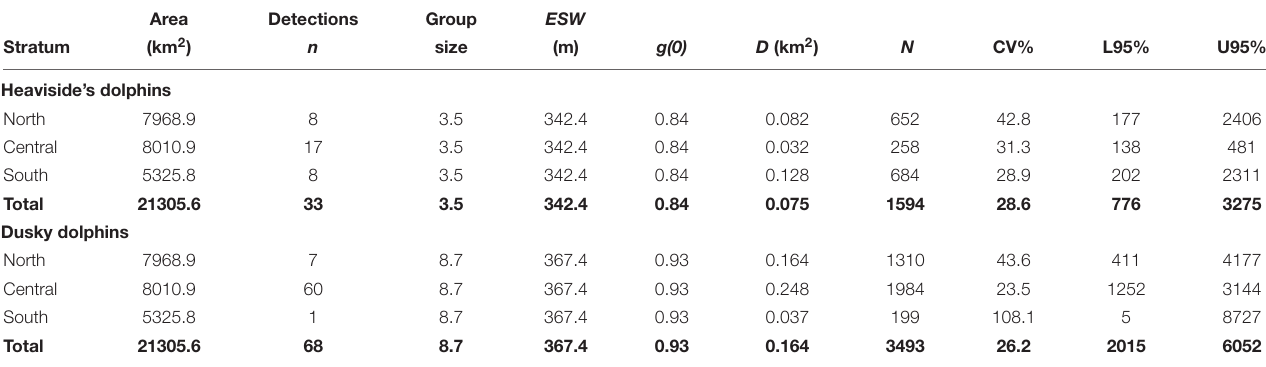
TABLE 5 | Estimates of Heaviside’s and dusky dolphin density and abundance in the study area derived from mark-recapture full independence (MR-FI) models. Area Detections Group ESW